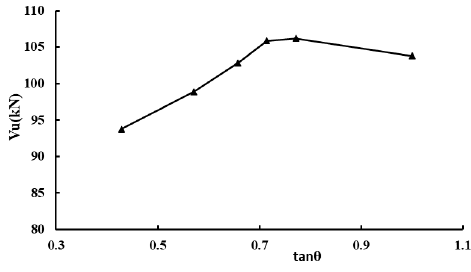
Figure 13. The curve of V u versus tan θ .